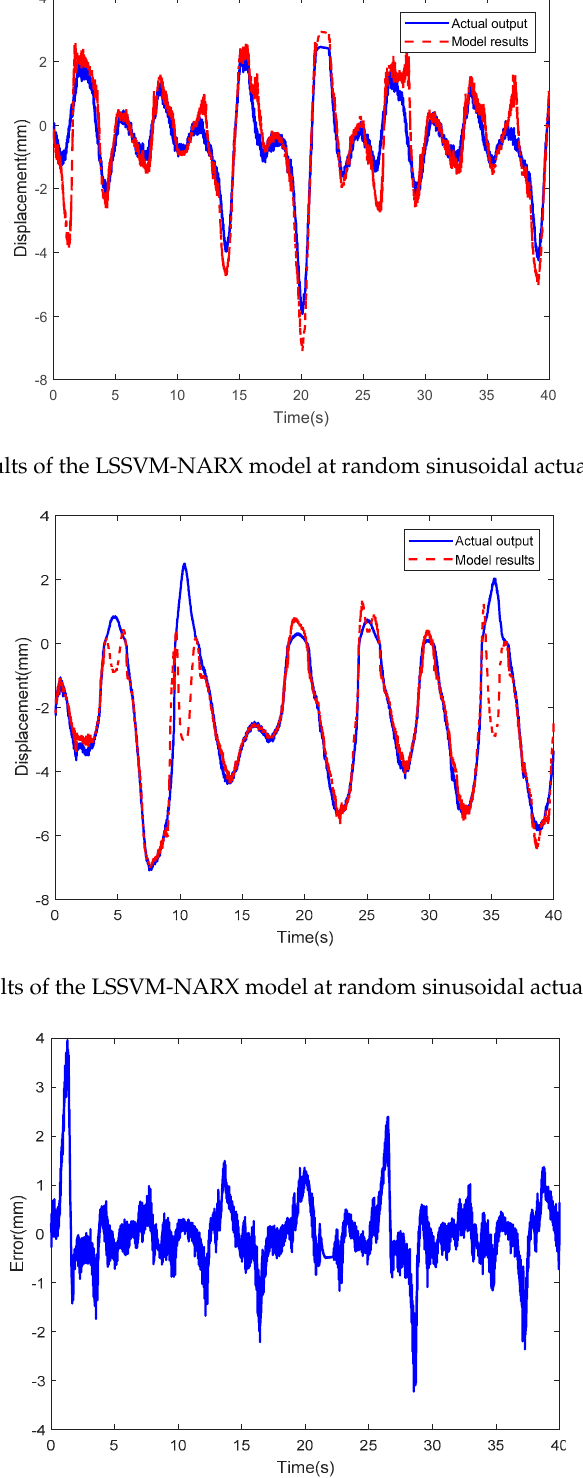
Figure 27. Error of the LSSVM ‐ NARX model at random sinusoidal actuating voltage I (RMSE = 0.6695).